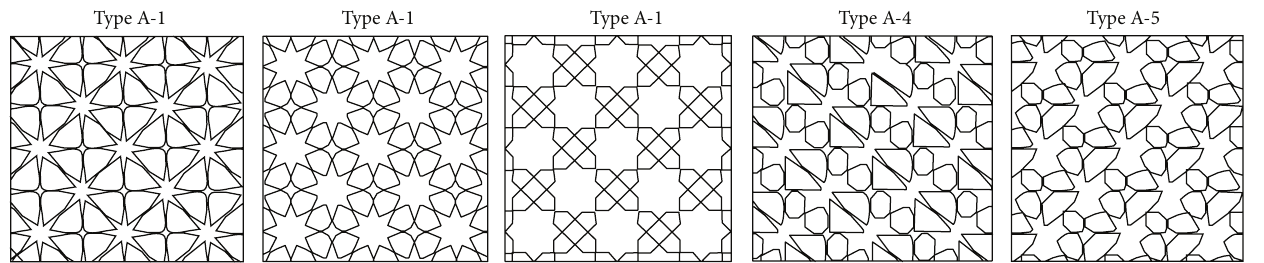
Figure 23: Type A patterning.